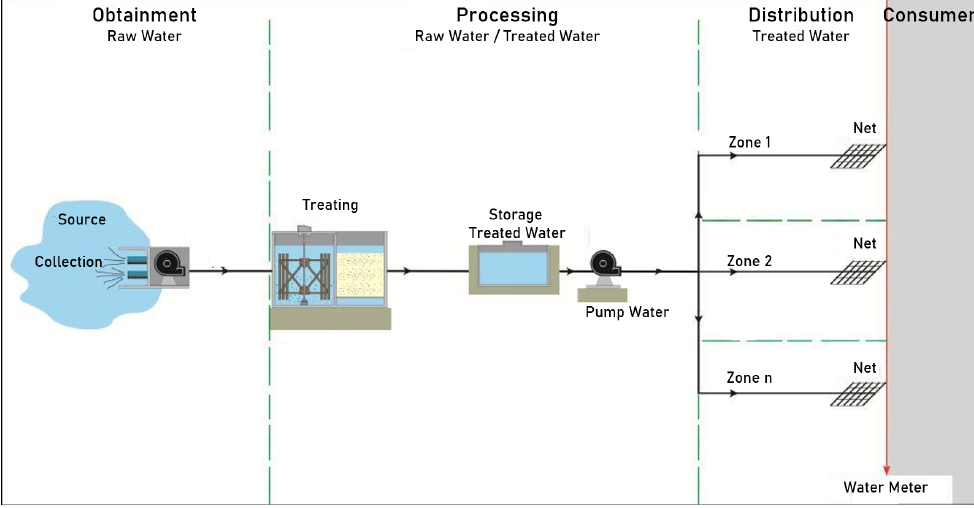
Figure 1. Details of operation of a water